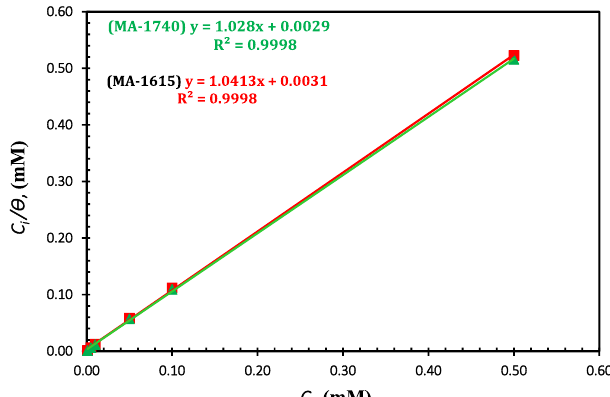
Figure 10. Langmuir adsorption plots for the cationic aryl bithiophene/terthiophene inhibitors on API 5L X70- type C-steel in 1 M HCl.